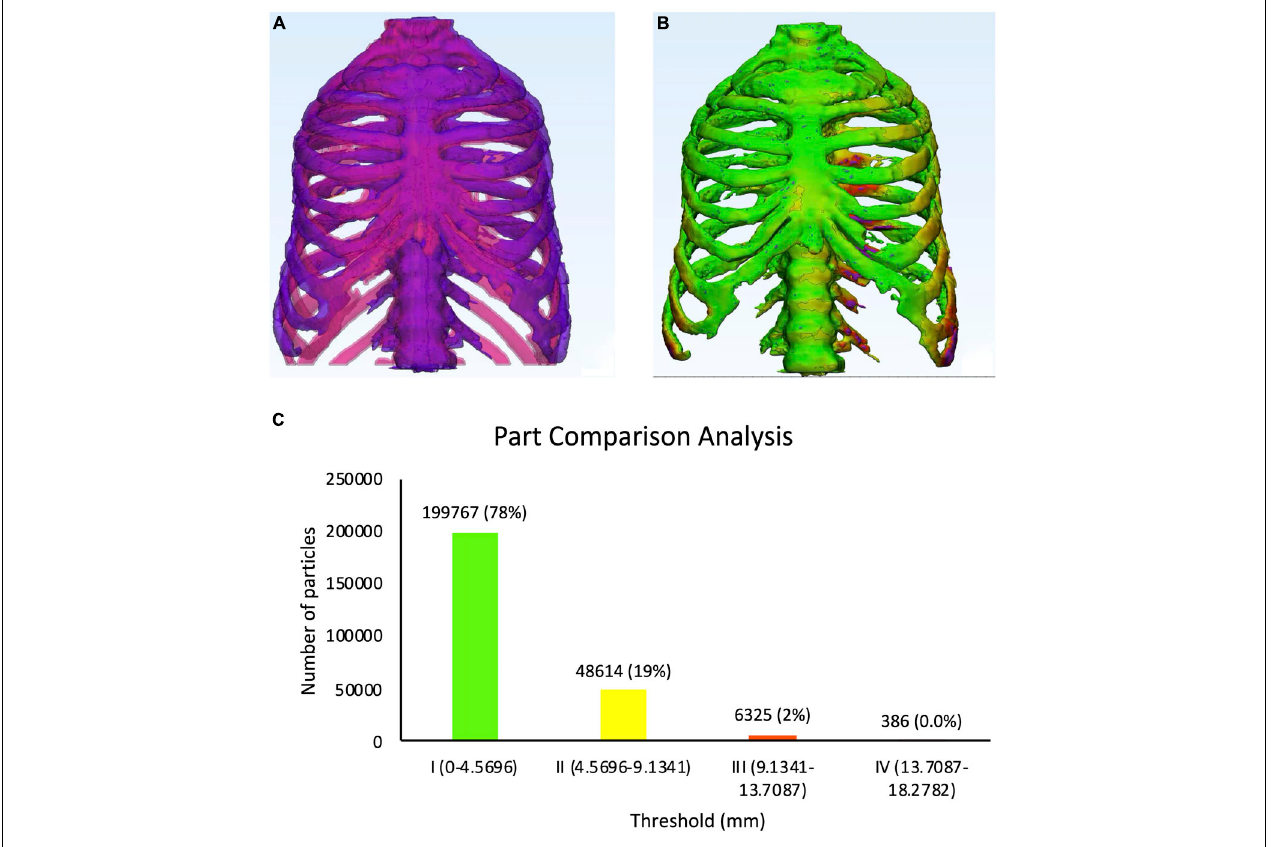
FIGURE 9 | Physical dimensional comparison of 3D printed thorax phantom with the patient (A) Registration of a CT-derived STL of the 3D printed thorax phantom (purple) on the patient thorax CT-derived STL(pink) using anatomic landmarks in 3-Matic 13.0 software, (B) Color-coded result of Part comparison analysis, (C) Graph explaining the color-coding based quantification of element overlap; 78% elements on the patient thorax overlap with the 3D printed thorax phantom. TABLE 3 | Detailed description of the histogram of segmentation analysis of the PPCA between the STL files acquired from patient and phantom thorax CT. Threshold